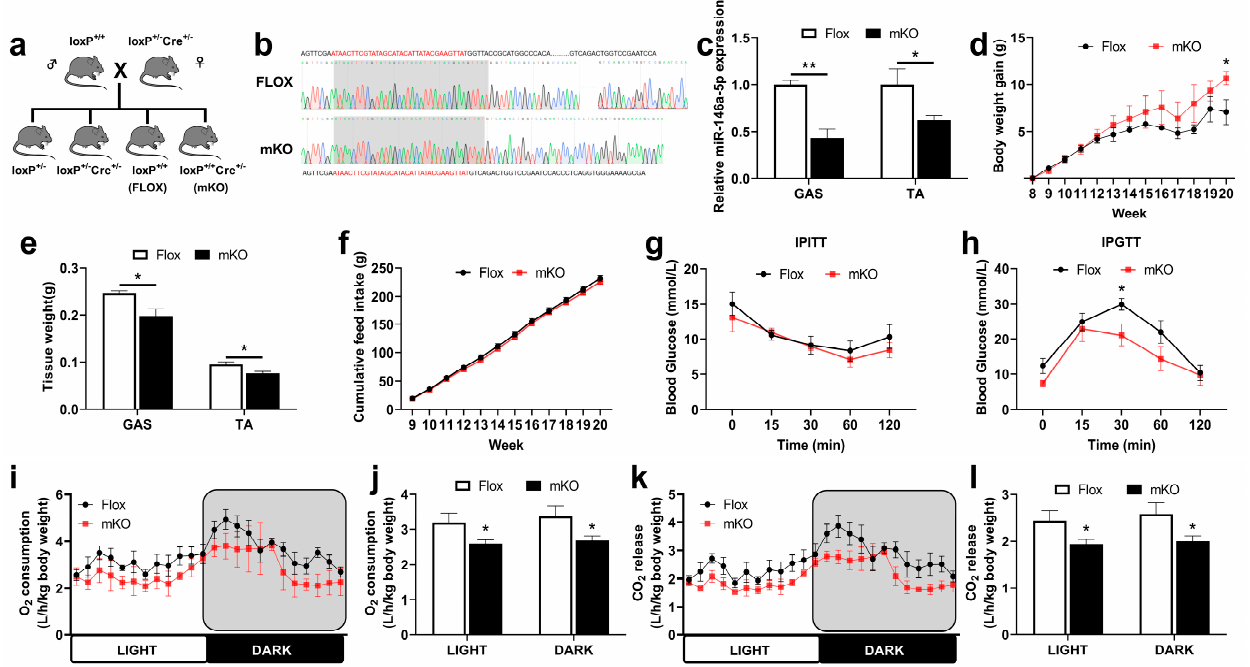
Figure 5. Regulations of growth and metabolism in transgenic mice. ( a ) Mice breeding atlas. ( b ) Sequence alignment of skeletal muscle-specific miR-146a-5p knockout (mKO) and Flox. ( c ) The expression of miR-146a-5p in GAS and TA of mKO mice was detected by quantitative PCR (n = 4). ( d ) Body weight change curve of Flox and mKO mice fed a high-fat diet (n = 4). ( e ) The muscle weight for GAS and TA of Flox and mKO mice fed a high-fat diet (n = 4). ( f ) Accumulate feed intake of Flox and mKO fed HFD (n = 4). ( g ) IPITT blood glucose changes in Flox and mKO mice (n = 4). ( h ) IPGTT blood glucose changes in Flox and mKO mice (n = 4). ( i , j ) Oxygen consumption (n = 4). ( k , l ) CO 2 release (n = 4). Values are presented as means ± SEM, * p < 0.05, and ** p < 0.01, according to the non-paired Student’s t-test or one-way ANOVA between individual groups.